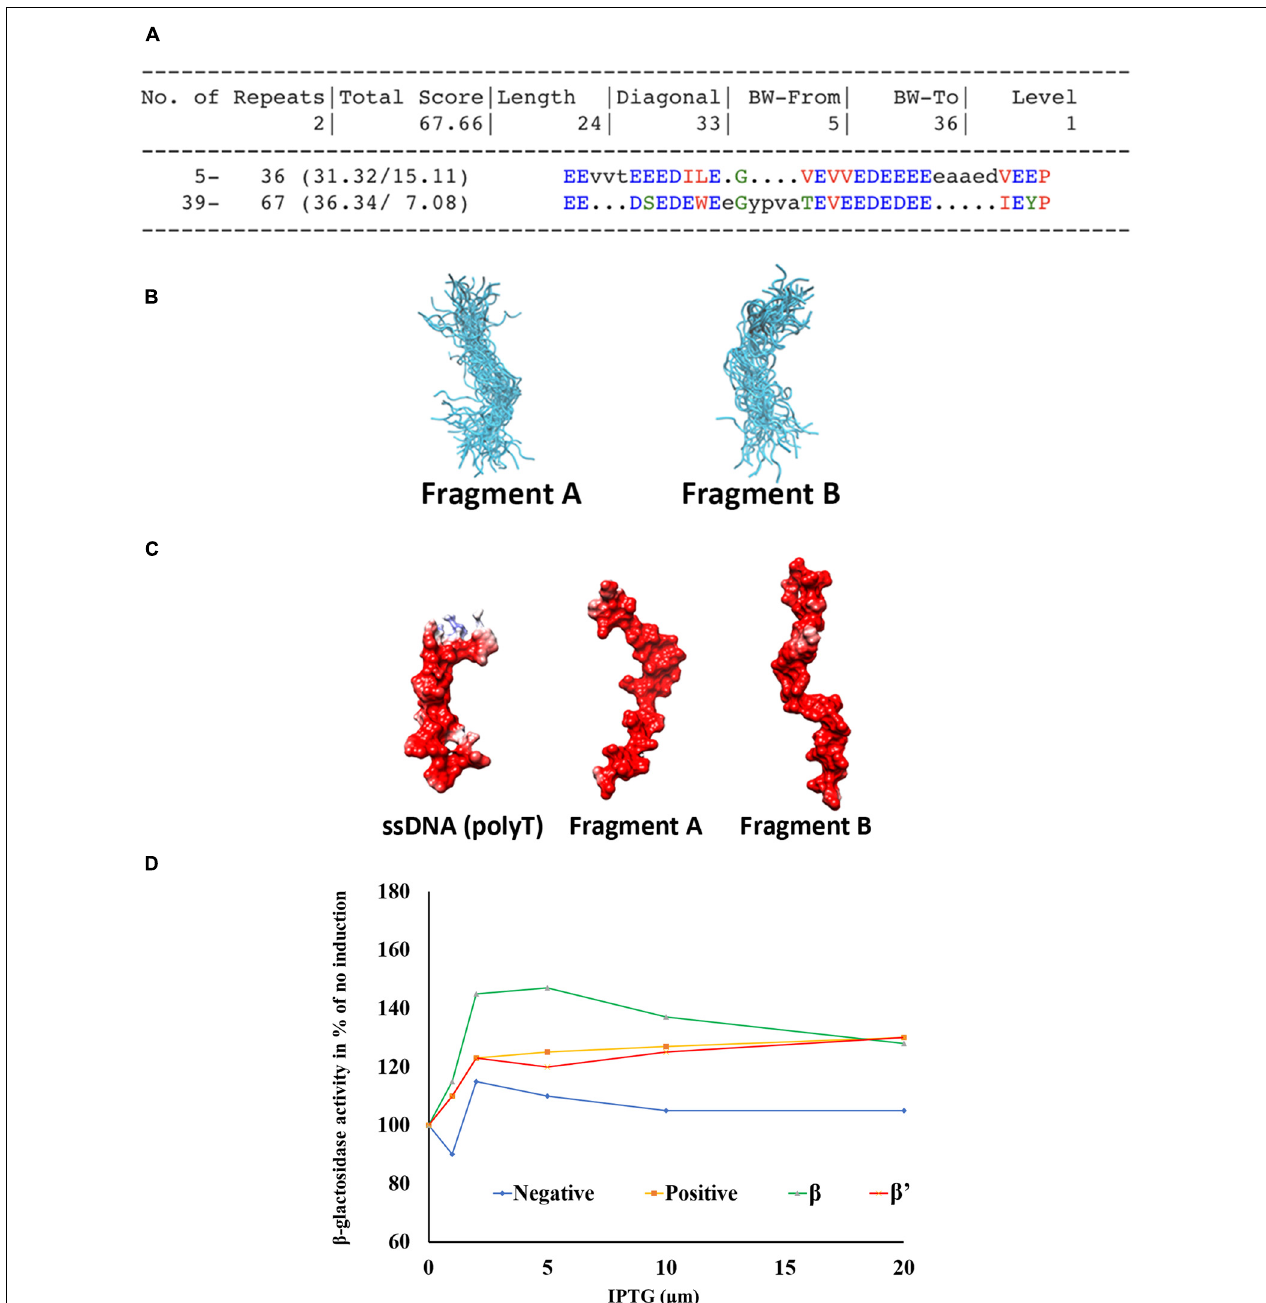
FIGURE 4 | Domain 56–122 of Gp44 mimics single strand DNA. (A) Two conserved repeats (Fragment A and B) of Gp44 56 - 122 were extracted using RADAR. (B) The cartoon representation of the ensembles of disordered conformations populated by fragments A and B during the simulation. (C) The negatively charged and highly flexible nature of fragment A and B is comparable to that of single-stranded DNA—poly-Thymidine (Left). (D) BTH assay shows Gp44 56 - 122 interacts with β and β (cid:48) subunits of B. subtilis .